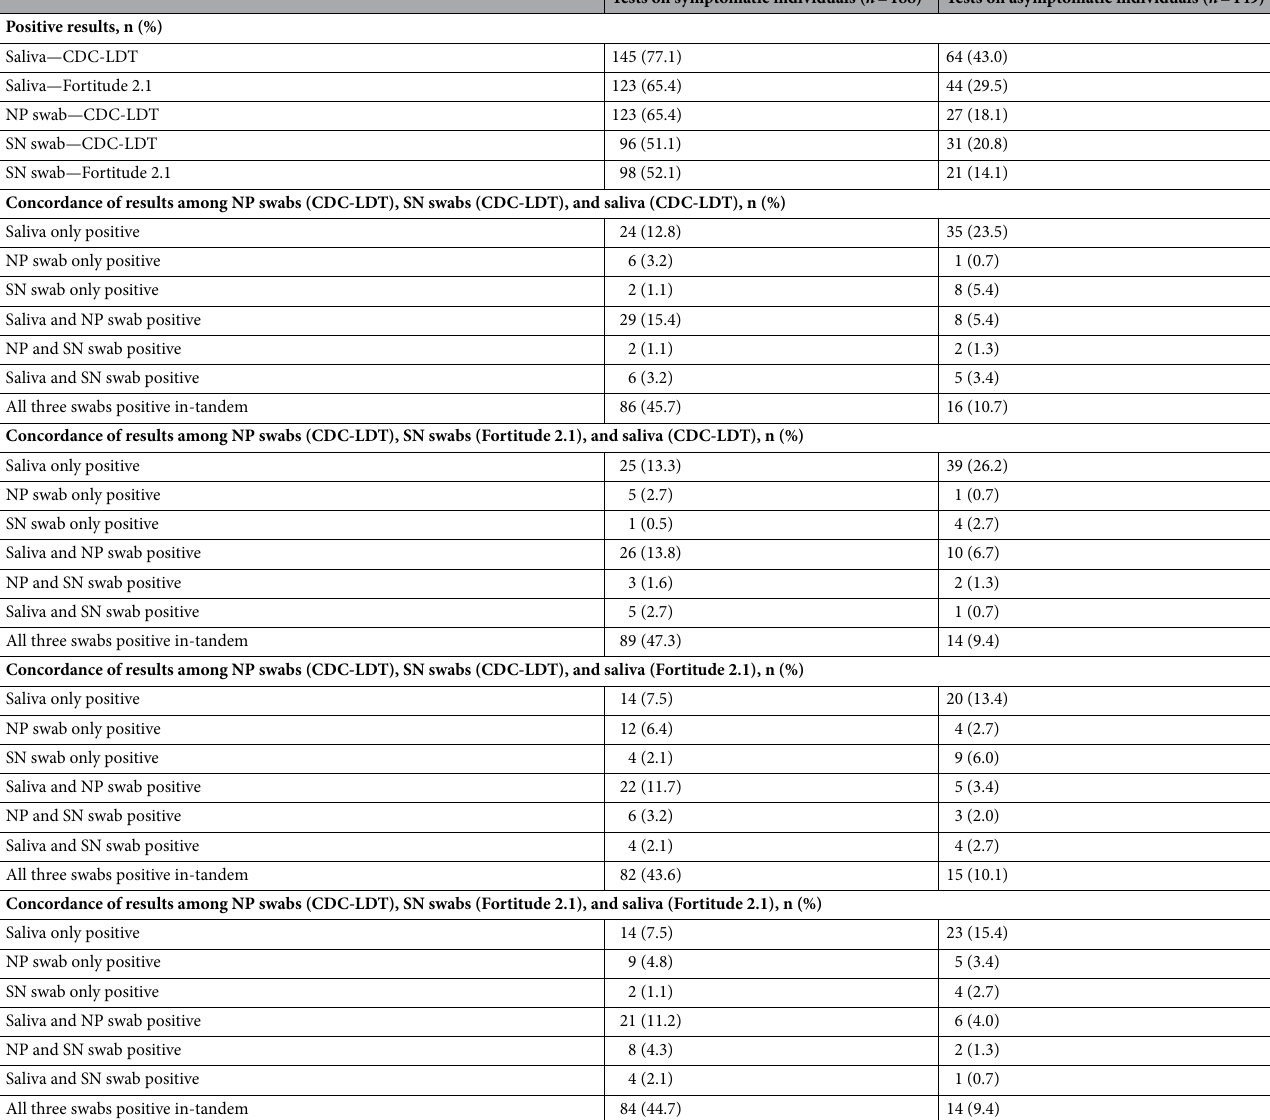
Table 2. Results of RT-PCR testing on samples. NP nasopharyngeal, SN self-administered nasal, CDC-LDT Centers for Disease Control and Prevention-Laboratory Developed